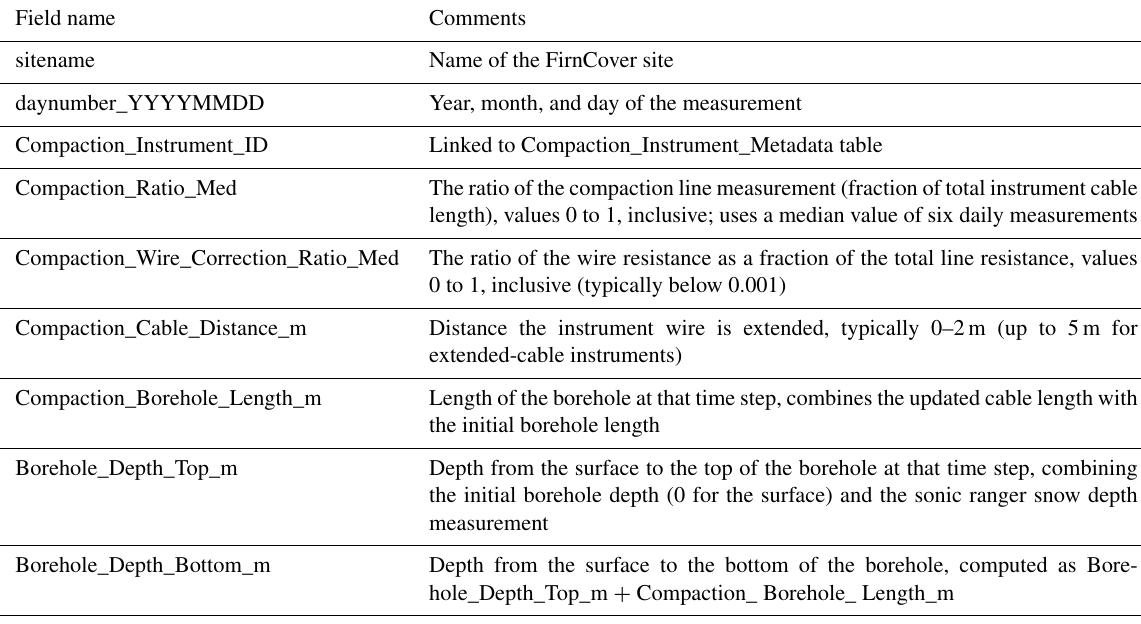
Table A1. Compaction_Daily table, storing daily compaction records for each FirnCover instrument.